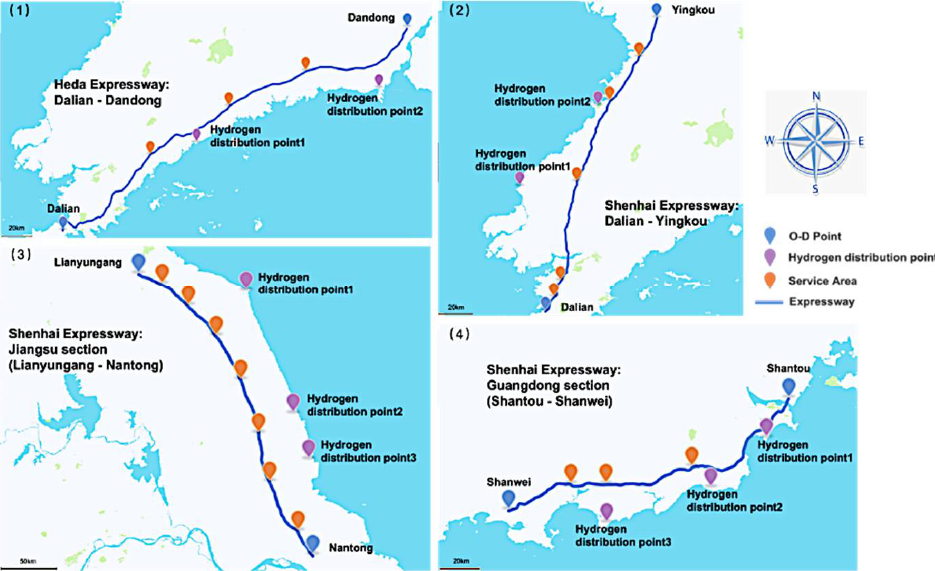
Figure 7. Schematic of expressway and service area and hydrogen distribution point. (Note: This map is made based on the standard MAP GS(2021)6375 of AmAP, and the base map is not modi- fied). ( 1 ) Schematic of Dalian-Dandong expressway and service area and hydrogen distribution point. ( 2 ) Schematic of Dalian-Yingkou expressway and service area and hydrogen distribution point. ( 3 ) Schematic of expressway in Jiangsu section and service area and hydrogen distribution point. ( 4 ) Schematic of expressway in Guangdong section and service area and hydrogen distribu- tion point. Table 10. Summary of location of hydrogen distribution point (Hdp).